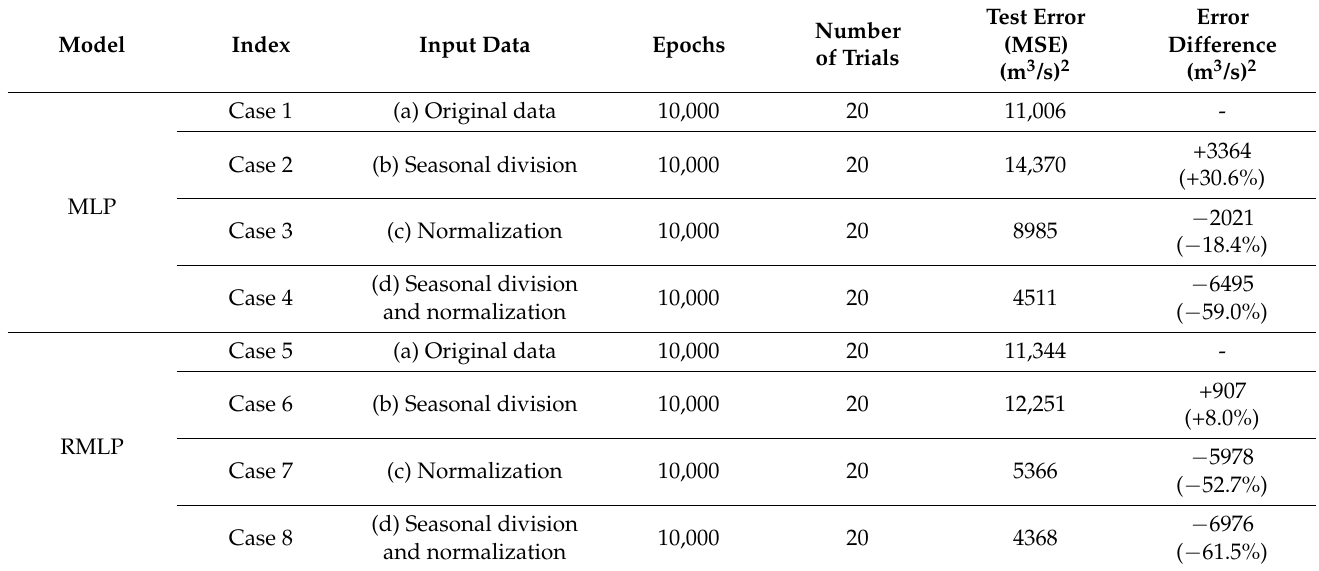
Table 7. Model performance and error analysis by